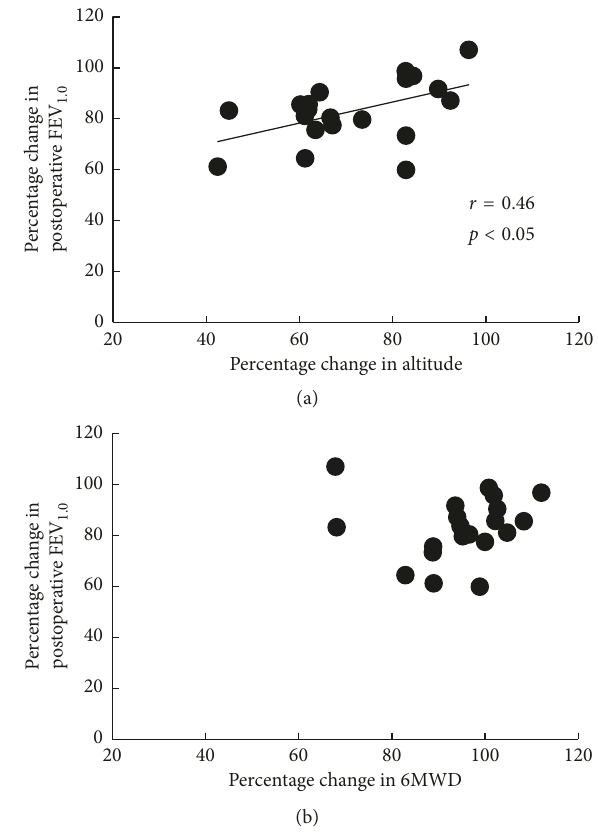
Figure 2: Correlation between percentage changes in altitude reached in the (a) stair-climbing test and (b) 6MWD and those in FEV 1.0 values at 1 month after surgery. Altitude, altitude reached in the stair-climbing test; 6MWD, 6-min walk distance; FEV 1.0 , forced expiratory volume in 1s.